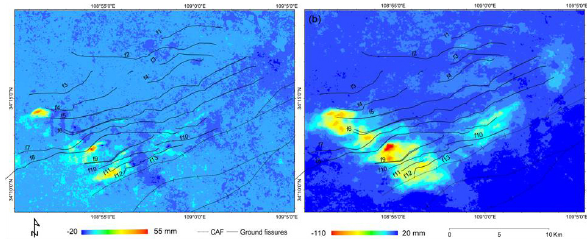
Figure 6. 2-D deformation map in 2009 by using ascending ALOS and descending Envisat ASAR data, whose coverages are marked on Fig. 1 in pink dash line: (a) the east-west component of the de- formation field; (b) the vertical component of the deformation